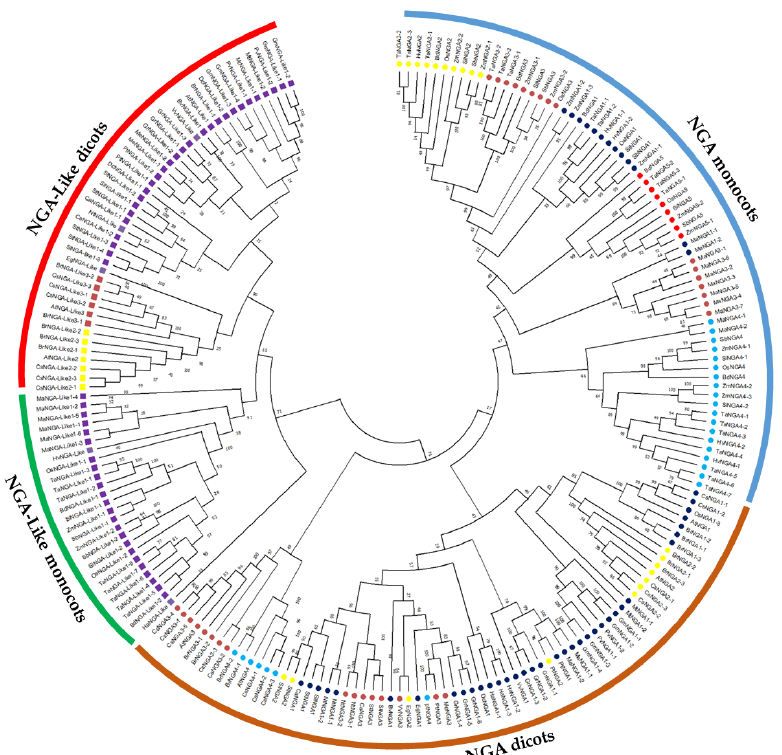
Figure 1. Phylogenetic analysis of the NGATHA family in crop plants. The phylogenetic tree was constructed using the NJ method with 1000 bootstrap replications in MEGA11. The NGATHA proteins were divided into distinct subfamilies with five NGA proteins and three NGA-Like proteins. The symbols are represented to each of the NGATHA proteins as follows. NGA1, NGA2, NGA3, NGA4, NGA5, NGA-Like1, NGA-Like2, NGA-Like3.